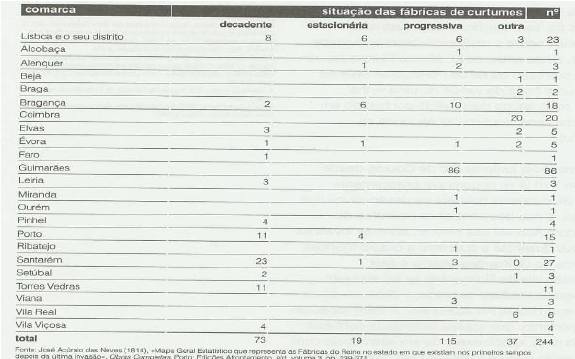
Figure 2. General Statistical Map showing the factories of the kingdom after the first invasion. (Neves, J. A, das 1814). Source: Obras completas Porto: Ediçoes Afrontamento, s/d,